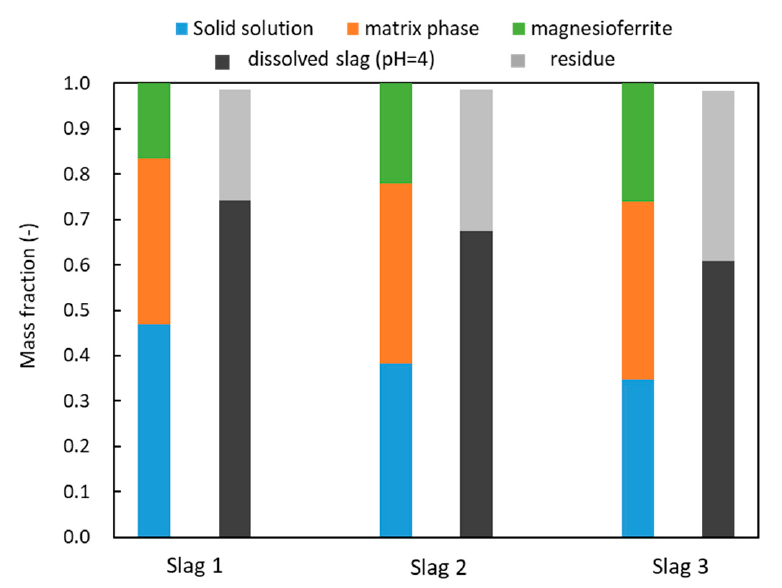
Figure 8. Mass fractions of mineral phases compared with that of dissolved slag in citric acid solution at pH 4.